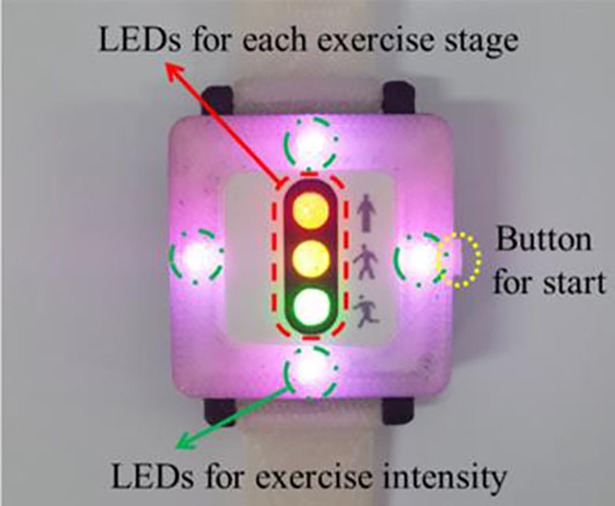
The DCRW front face.